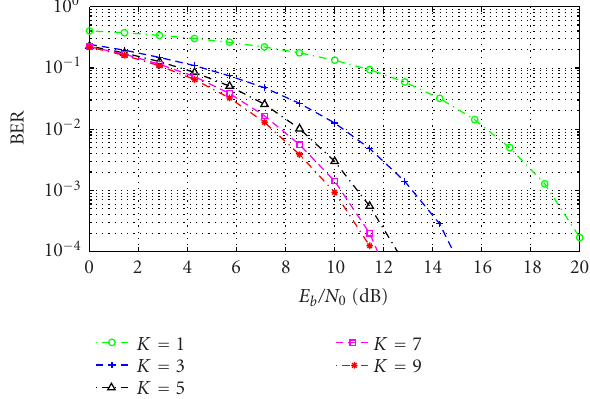
Figure 9: BER performance in AWGN with di ff erent observation intervals K , and parameters K BT = 0 . 5, h = 0 .